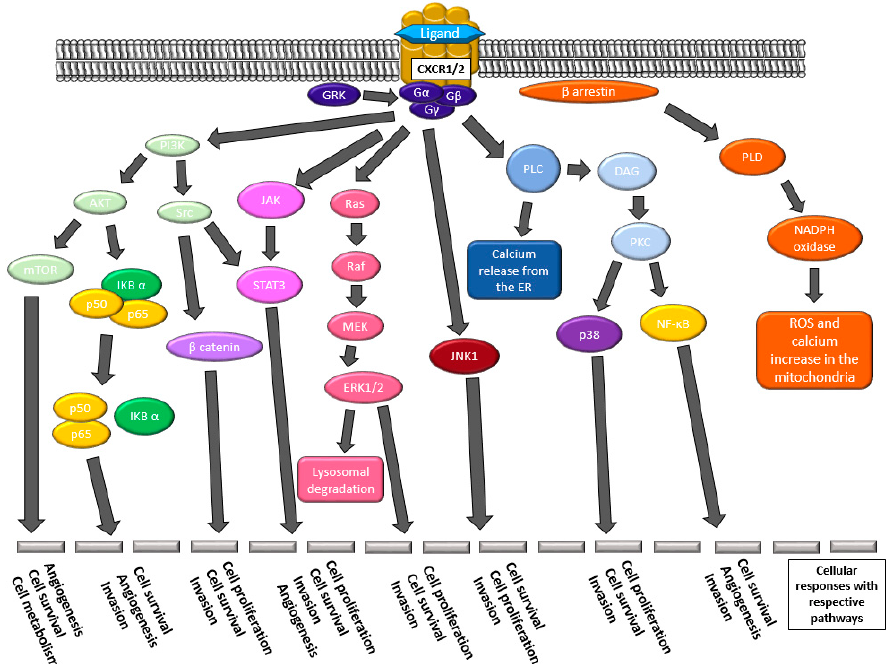
Figure 2. The downstream effectors of pathways elicited by the activation of CXCR1/2 by their respective ligands. Many pathways lead to angiogenesis, cellular survival and proliferation, metabolism changes, invasive properties, and increased expression of the CXCR1/2 ligands.